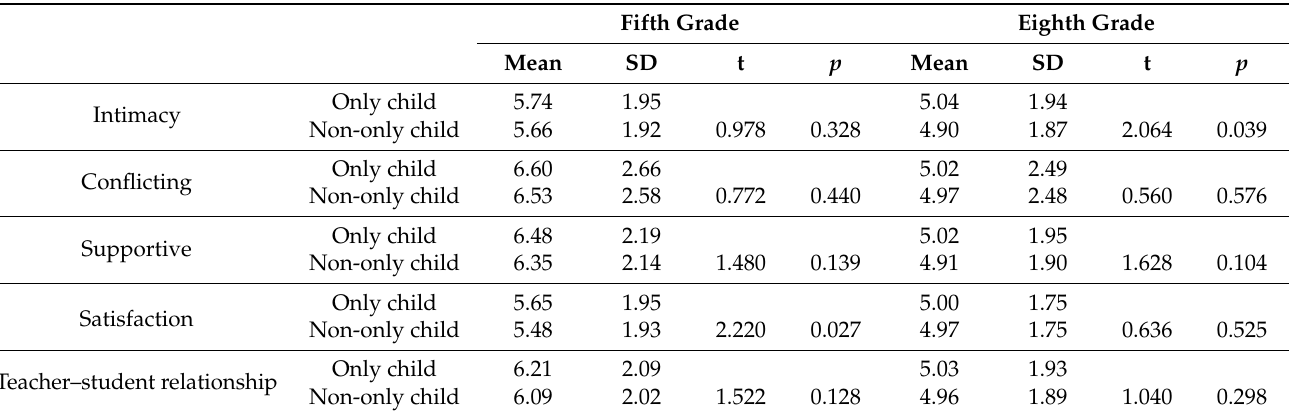
Table 12. Teacher-student relationships with intimacy, conflict, and supportive dimensions af- ter matching.